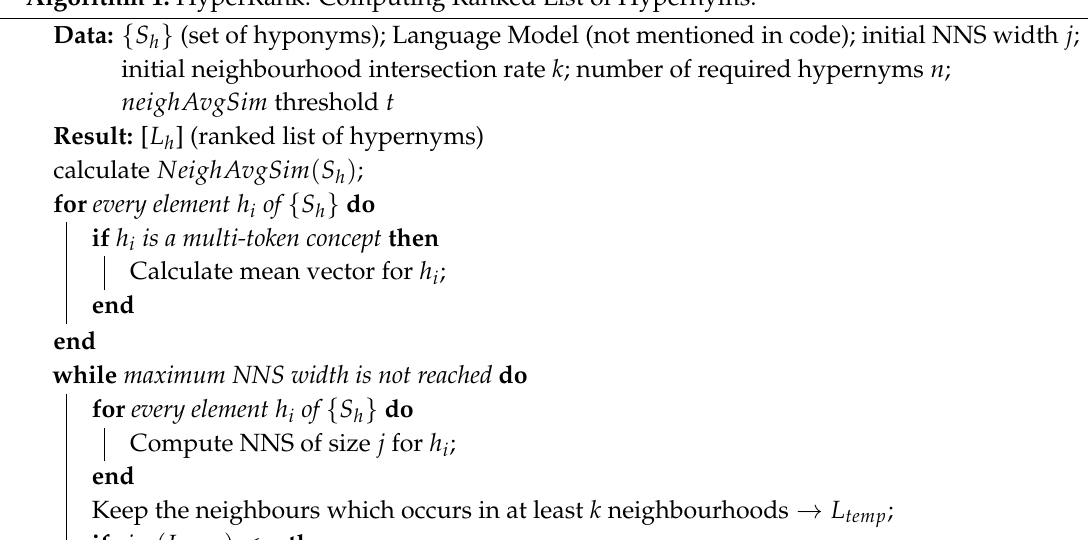
Algorithm 1: HyperRank: Computing Ranked List of Hypernyms.